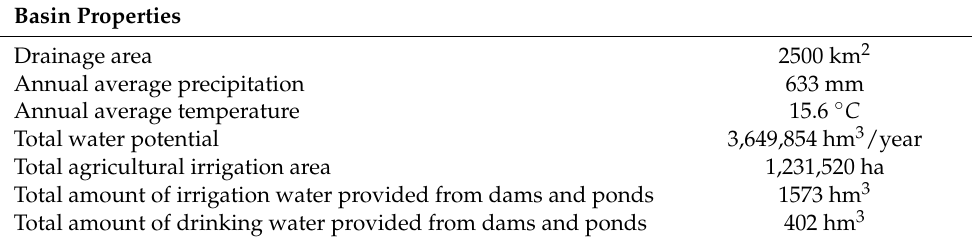
Table 1. Characteristics of B. Menderes River